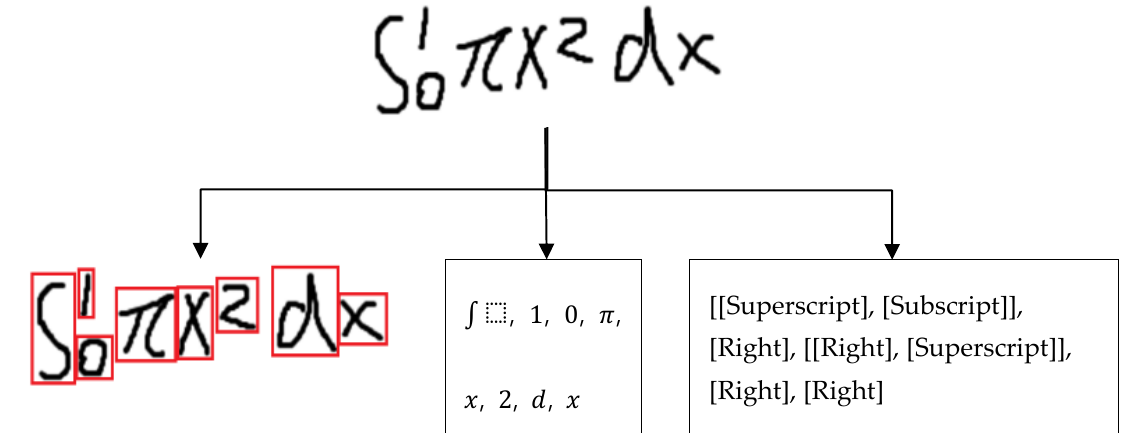
Figure 2. Recognition process of handwritten mathematical expressions.